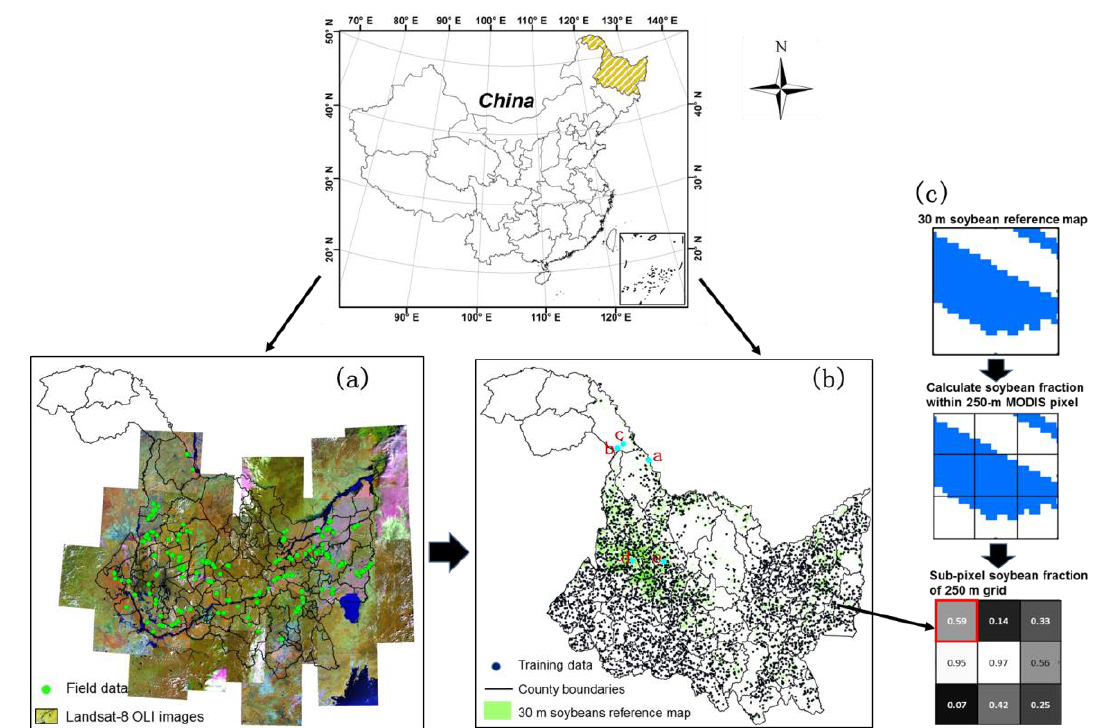
Figure 1. ( a ) Landsat-8 OLI images and field data (green dots) used to derive the 30-m soybean reference map; ( b ) 30 m soybean reference map, from which 4000 training points (blue dots) were selected as training data for GWR model; ( c ) An example to illustrate how soybean fraction was calculated at 250-m grid based on the 30-m soybean reference map.